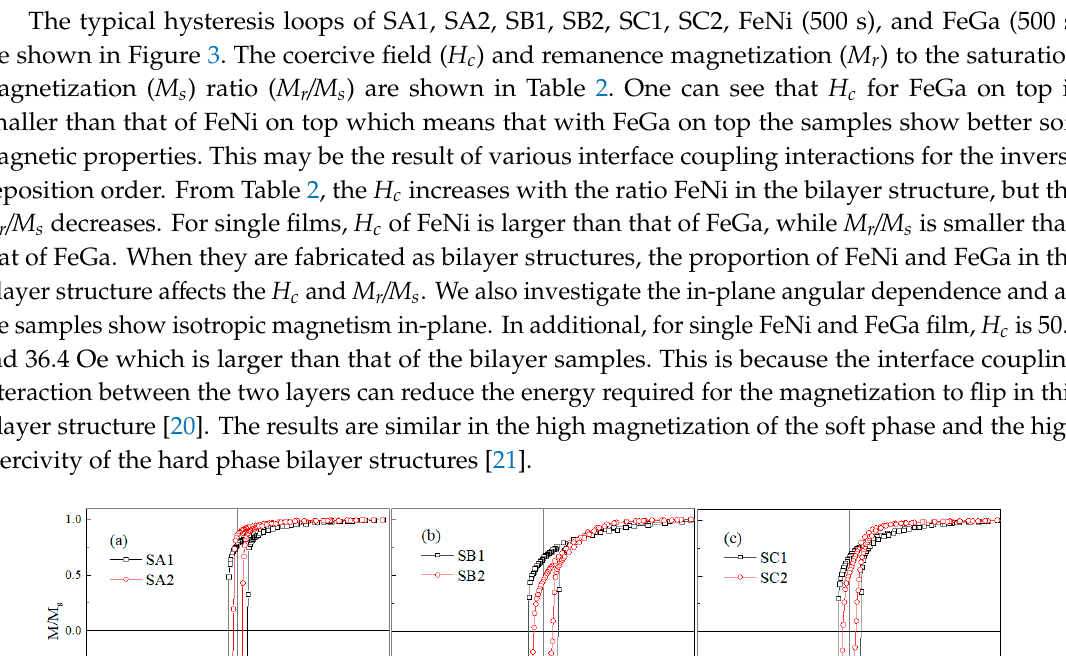
Figure 2. SEM image of SA1 ( a ), SA2 ( b ), SB1 ( c ), SB2 ( d ), SC1 ( e ), and SC2 ( f ). The insets show SEM cross-sectional images of the films.